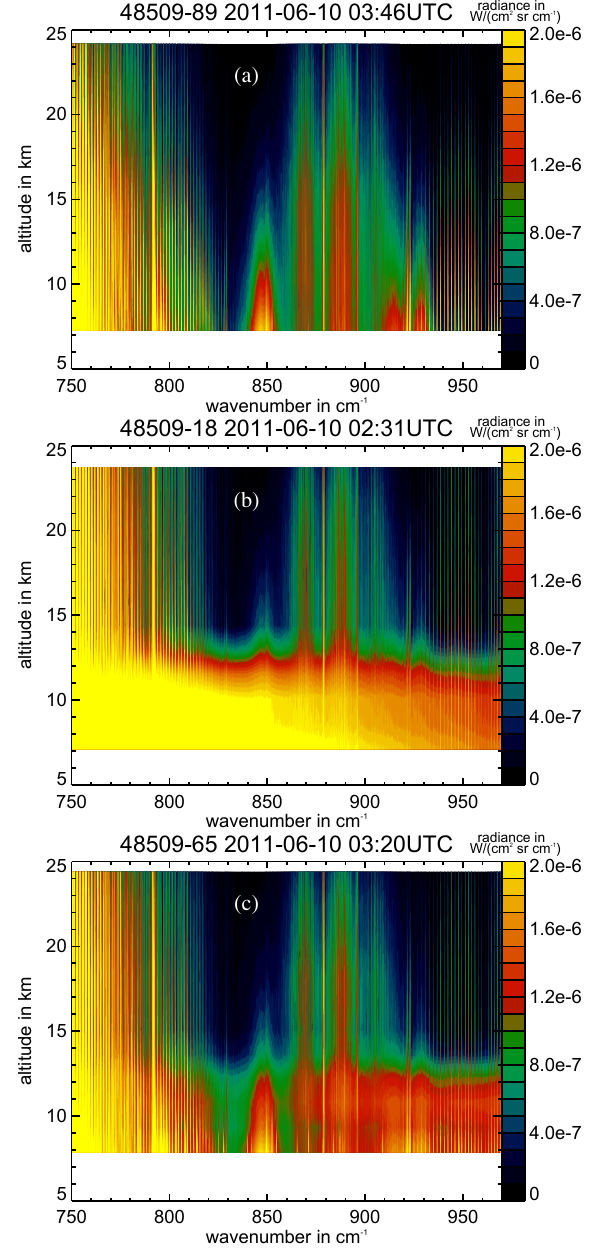
Figure 4. MIPAS radiances for three profiles of orbit 48509. Fig. 4. MIPAS radiances for three profiles of orbit 48509. (a) Clear (a) Clear air with low radiances in window regions around 830 and air with low radiances in window regions around 830 and 950cm − 1 . 950cm − 1 . (b) Ice cloud below 13km. The radiances at 830cm − 1 (b) Ice cloud below 13km. The radiances at 830cm − 1 are much are much larger than at 950cm − 1 . (c) Volcanic ash layer below larger than at 950cm − 1 . (c) Volcanic ash layer below 13km. The 13km. The radiances at 830cm − 1 are lower than at 950cm − 1 . radiances at 830cm − 1 are lower than at 950cm − 1 .